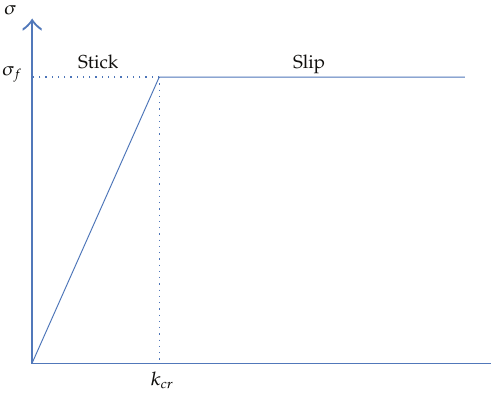
Figure 9: Definition of friction